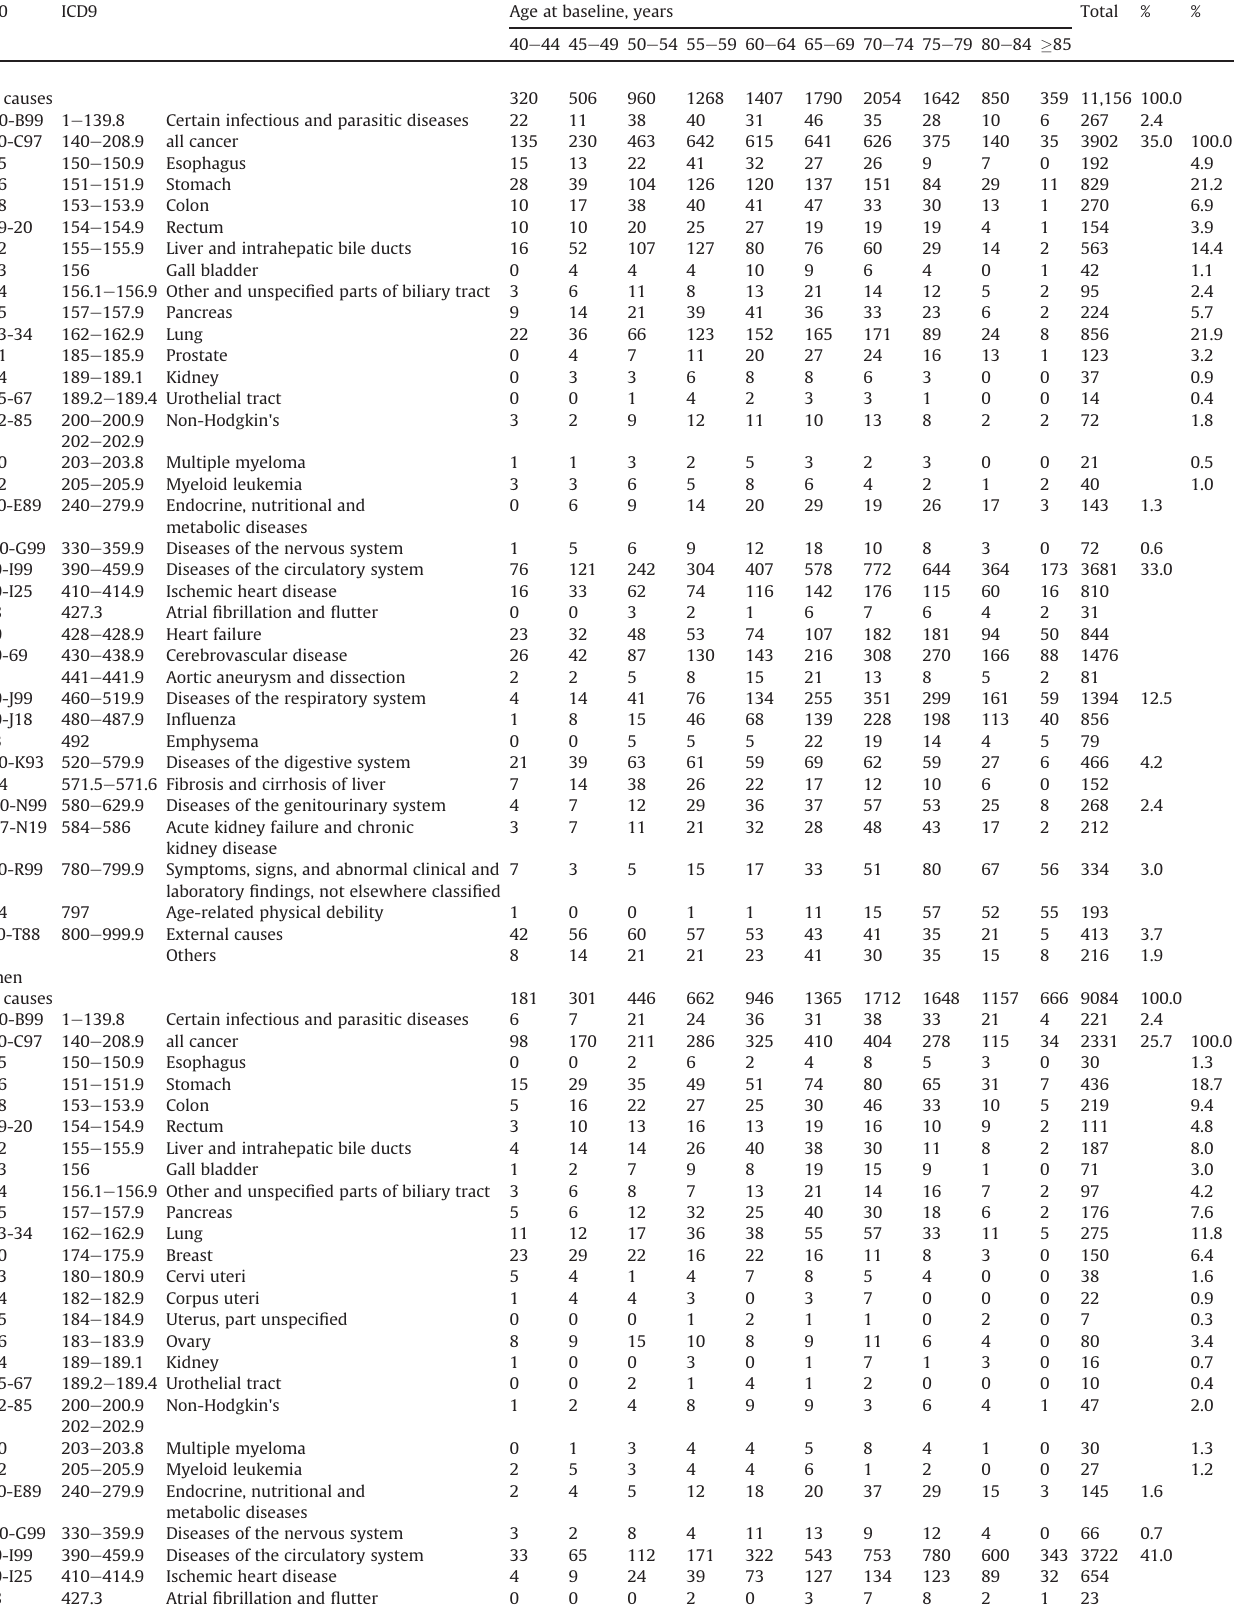
Table 6 Distribution of number of deaths by cause, gender, and age at baseline during 15-year follow-up. ICD10 ICD9 Age at baseline, years Total %